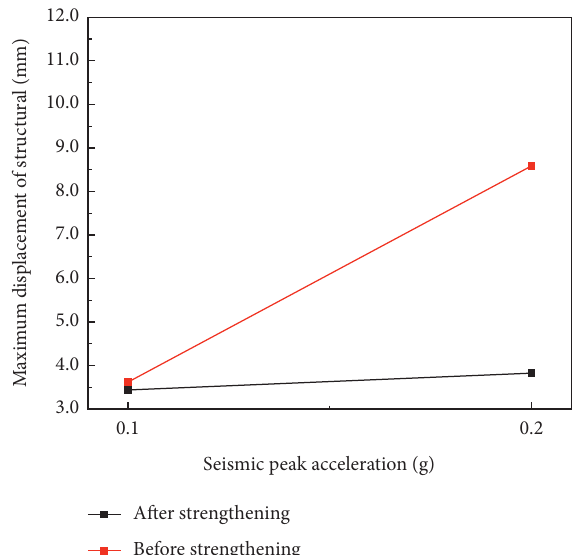
Figure 18: Comparison of the maximum displacement of the structure under EL-Centro earthquake.